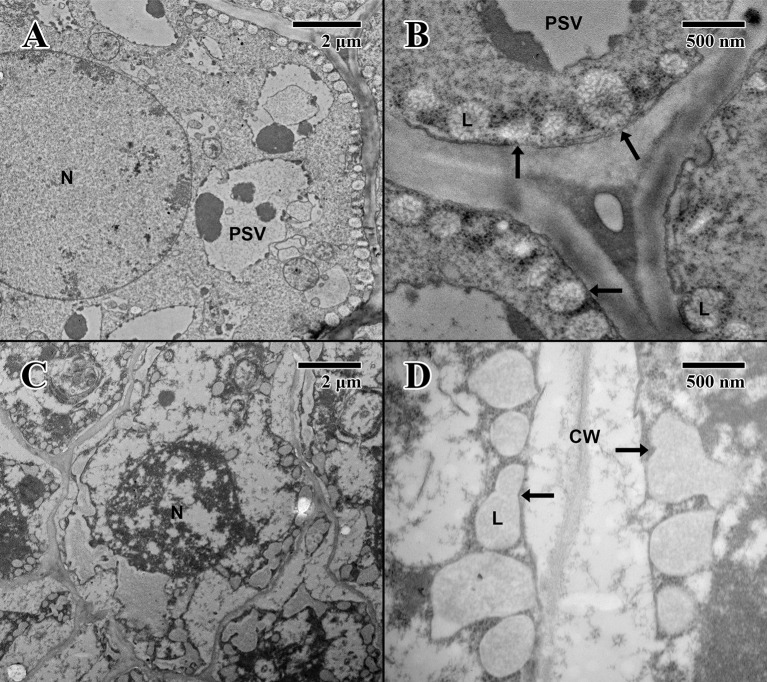
Transmission electron microscope micrographs of epicotyl region of date palm embryos in imbibed state. (A) ×2,500 2004 embryo. Scale bar = 2 μm. (B) 10,000 2004 embryo. Scale bar = 500 nm. (C) ×2,500 1873 embryo (EBC accession no. 36011). Scale bar = 2 μm. (D) ×10,000 1873 embryo (EBC accession no. 36011). Scale bar = 500 nm. (N, nucleus; CW, cell wall; L, lipid body; PSV, protein storage vacuole; arrows = explained in text.).